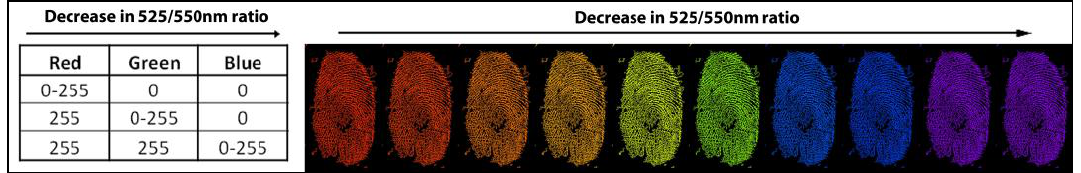
Figure 3. Use of Red-Green-Blue colours to produce false colour scales based on the 525/550 nm ratio.